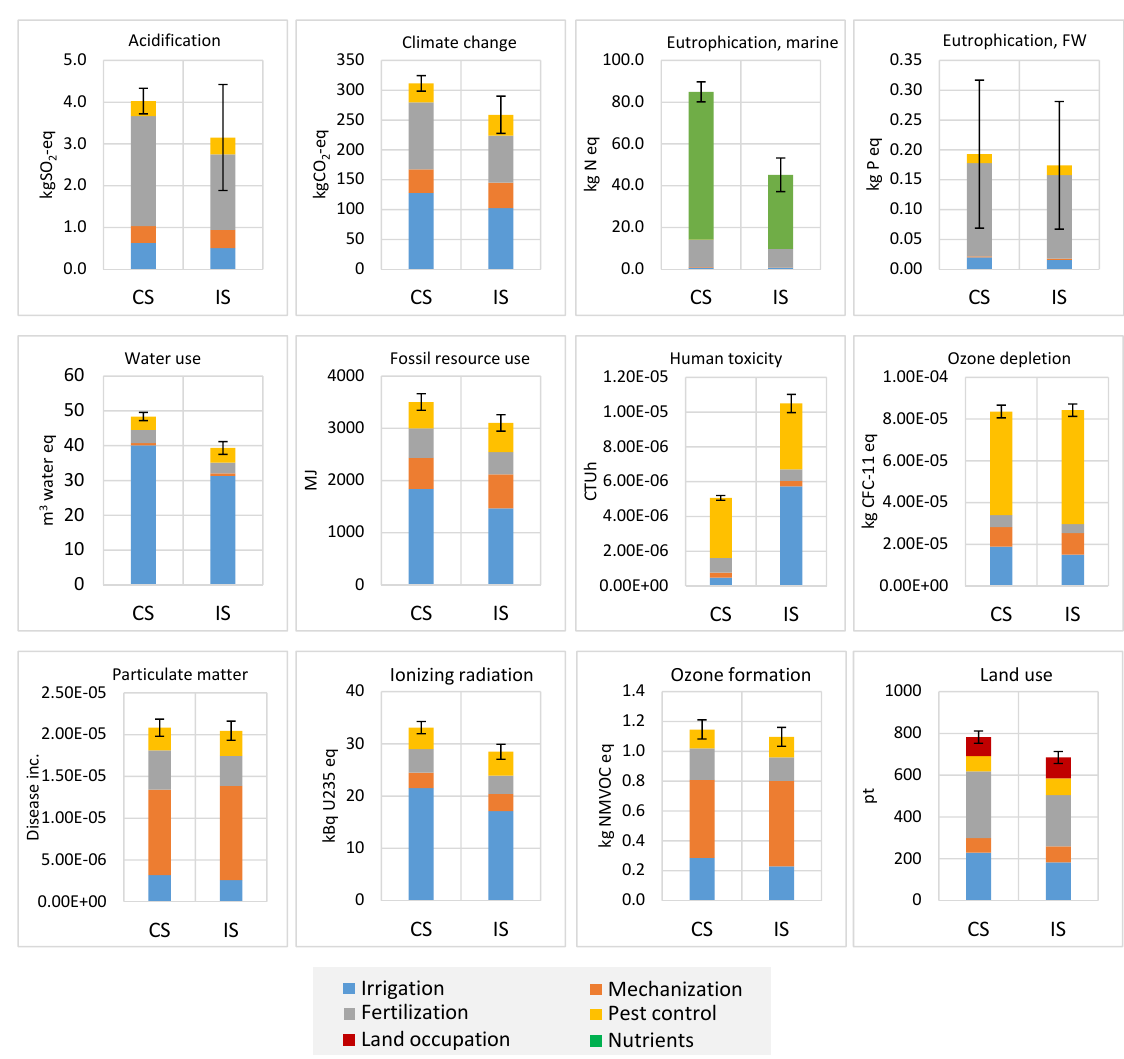
Figure 5. Results and contributions for different impact categories for conventional (CS) and integrated system (IS) per 1 ton of grapes with Monte Carlo standard deviations indicated with a black line. Reclamation impacts are integrated into irrigation process